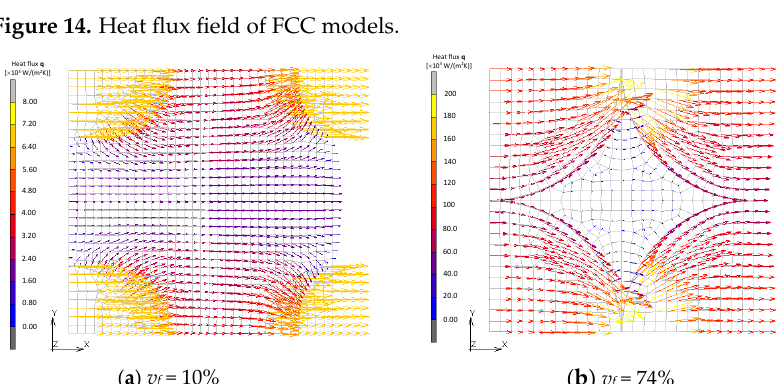
Figure 15. Heat flux field of transformed FCC models.